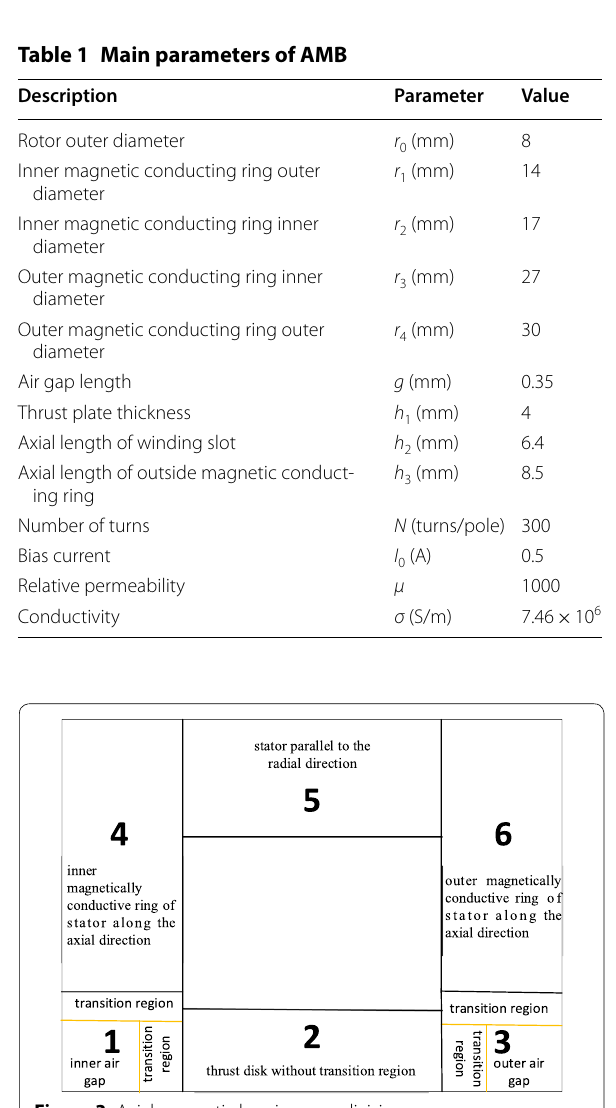
Figure 3 Axial magnetic bearing area